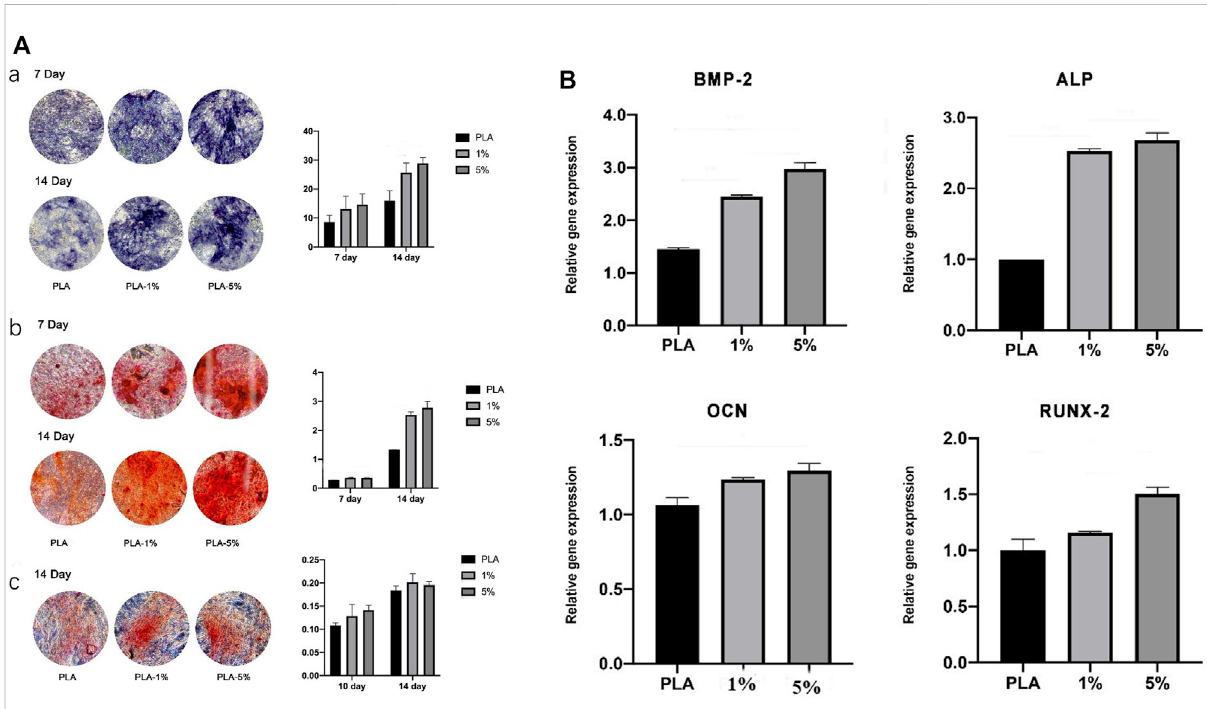
FIGURE 7 (A) . Evaluation of osteogenic differentiation of hBMSCs cultured with leaching solutions from PLA, 1% and 5% BG-PLA. a: ALP staining and statistical analysis;b: Alizarin redstainingand statistical analysis;c: Siriusred stainingand statisticalanalysis. (B) .Relative expressionofosteogenesis- related